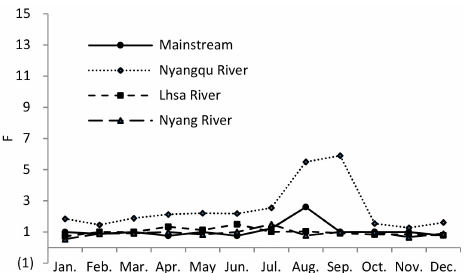
Figure 3. Spatial distribution of TP in the basin of the Yarlung Zangbo